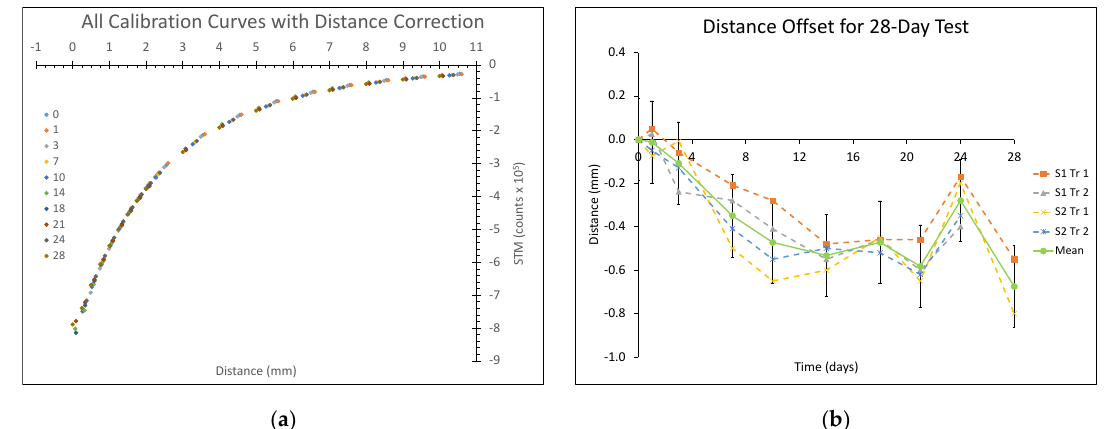
Figure 6. Results from the 28-day durability test. ( a ) Data from all test days corrected for distance offset (left shoe sample (Trial 1)). Results were comparable for both samples. ( b ) Distance offset over time for the first and second trials for both samples and the mean. S1 = left shoe sample; S2 = right shoe sample; Tr1 = Trial 1; Tr2 = Trial 2.